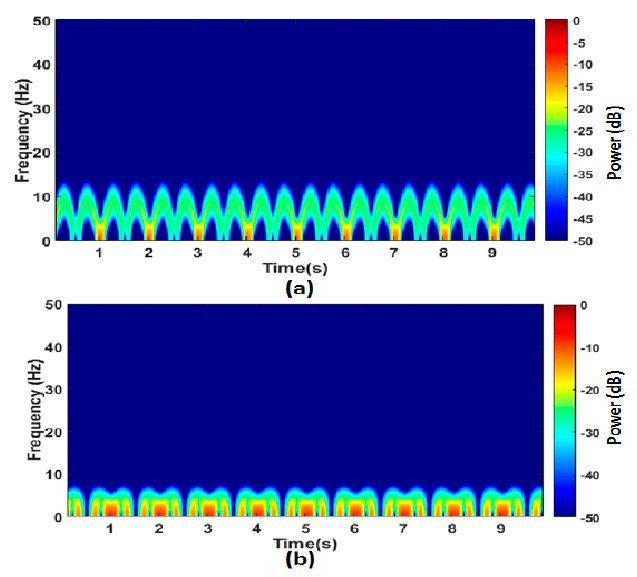
Figure 3. Spectrogram of the Doppler signature with one pendulum swinging on the BL with fixed pivot for initial angular displacement: ( a ) θ 0 = 40 ◦ ; and ( b ) θ 0 = 20 ◦